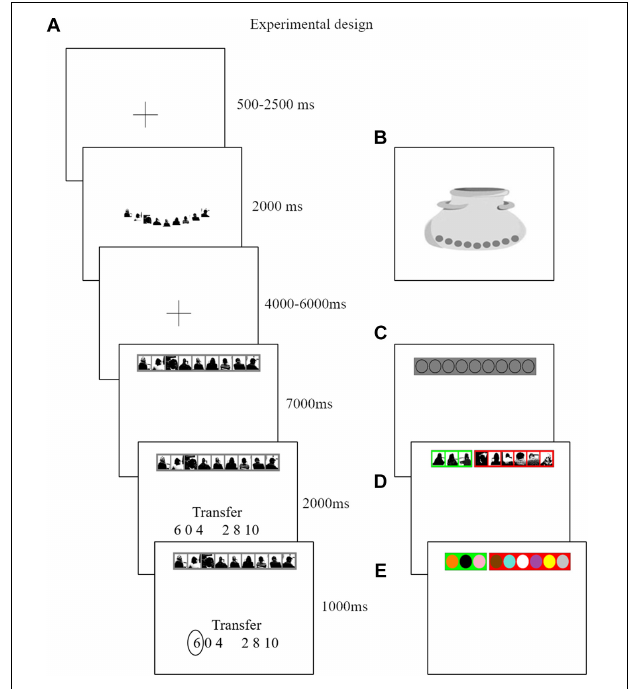
FIGURE 1 | Each trial consists of six screens. Panel (A) is an example of a trial from the ATG. The second screen indicates the source of uncertainty. Nine silhouettes are displayed when participants are in a social context. Nine marbles are displayed when participants face a lottery context Panel (B) . The fourth screen is the decision screen. They are instructed to decide how much to transfer here. As the six possible transfer options appear in a random order on the next screen, they are unable to prepare for a specific button press. On the last screen we confirm their choice. In the ATG Panel (A) nine silhouettes on a gray background indicate that no information is given about the distribution of receivers that decided to send back half or keep the investment. To illustrate the tailor-made structure of our design, we assume a participant who believes three out of nine receivers will reciprocate. In the ALOT Panel (C) the participant receives instruction that three out of nine colors that can be used in any combination in this lottery are winning colors. In this way we align underlying subjective probabilities between the ATG and ALOT. In the risky trials we align individual’s beliefs to objective probabilities. A participant who believes three out of nine receivers will reciprocate, will most often face a RTG, which is composed of three receivers (green background) that decided to send back half of any received investment versus six receivers (red background) that decided to keep their investment Panel (D) . Finally, in the RLOT the urn is composed of all nine colors out of which three are winning colors (green background) and six are losing colors (red background) Panel (E)